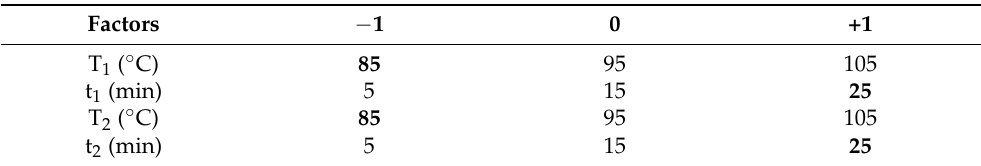
Figure 2. Schematic diagram of two-stage chemical derivatization and extraction approach. Table 1. Factors and levels tested for derivatization and extraction optimization using DoE. The optimized conditions are in bold.